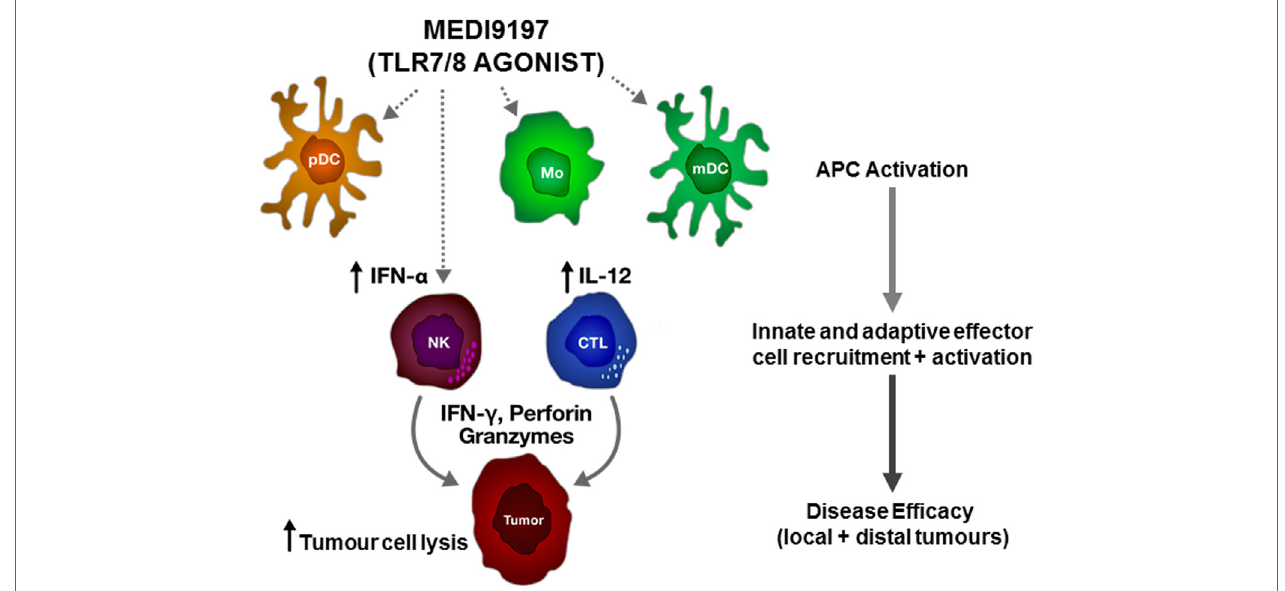
FiGURe 1 | Proposed mechanism of action of MEDI9197 following intratumoural administration. MEDI9197 activates toll-like receptor (TLR) 7 and 8 expressing cells, such as plasmacytoid dendritic cells (pDC), myeloid dendritic cells (mDC), and monocytes (Mo), which release type I interferons and pro-inflammatory cytokines, such as interleukin-12 (IL-12); leading to recruitment and activation of effector cells, including natural killer (NK) cells and cytotoxic T lymphocytes (CTL) to the tumor. The activated effector cells release interferon gamma (IFN- γ ), perforin, and granzymes to kill the tumor